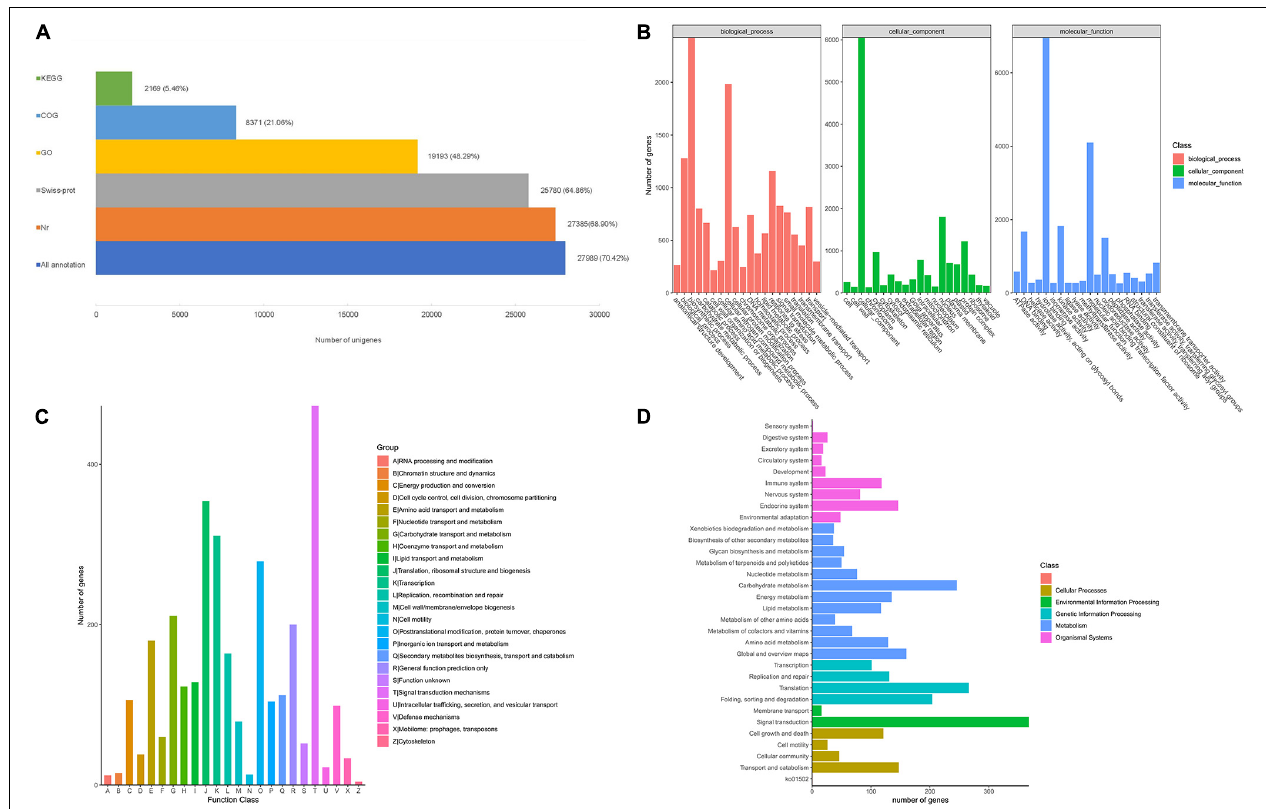
FIGURE 1 | Functional annotation of A. biserrata unigenes on the basis of public databases. (A) Summary of annotations of unigenes in five databases. (B) GO classification of annotated unigenes. (C) The COG functional distribution of annotated unigenes. (D) Functional classification of unigenes based on the KEGG